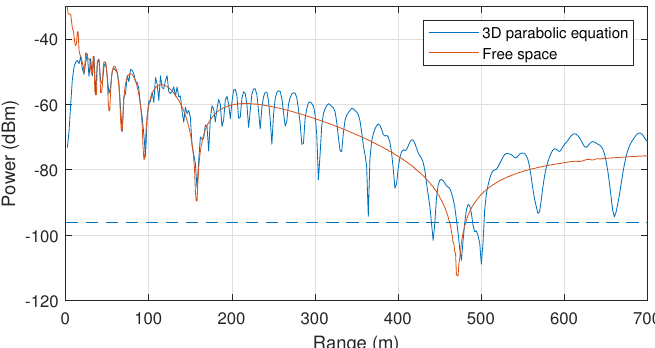
Figure 8. Propagation in a street canyon. Distribution of the signal level at the height of 1.5 above the